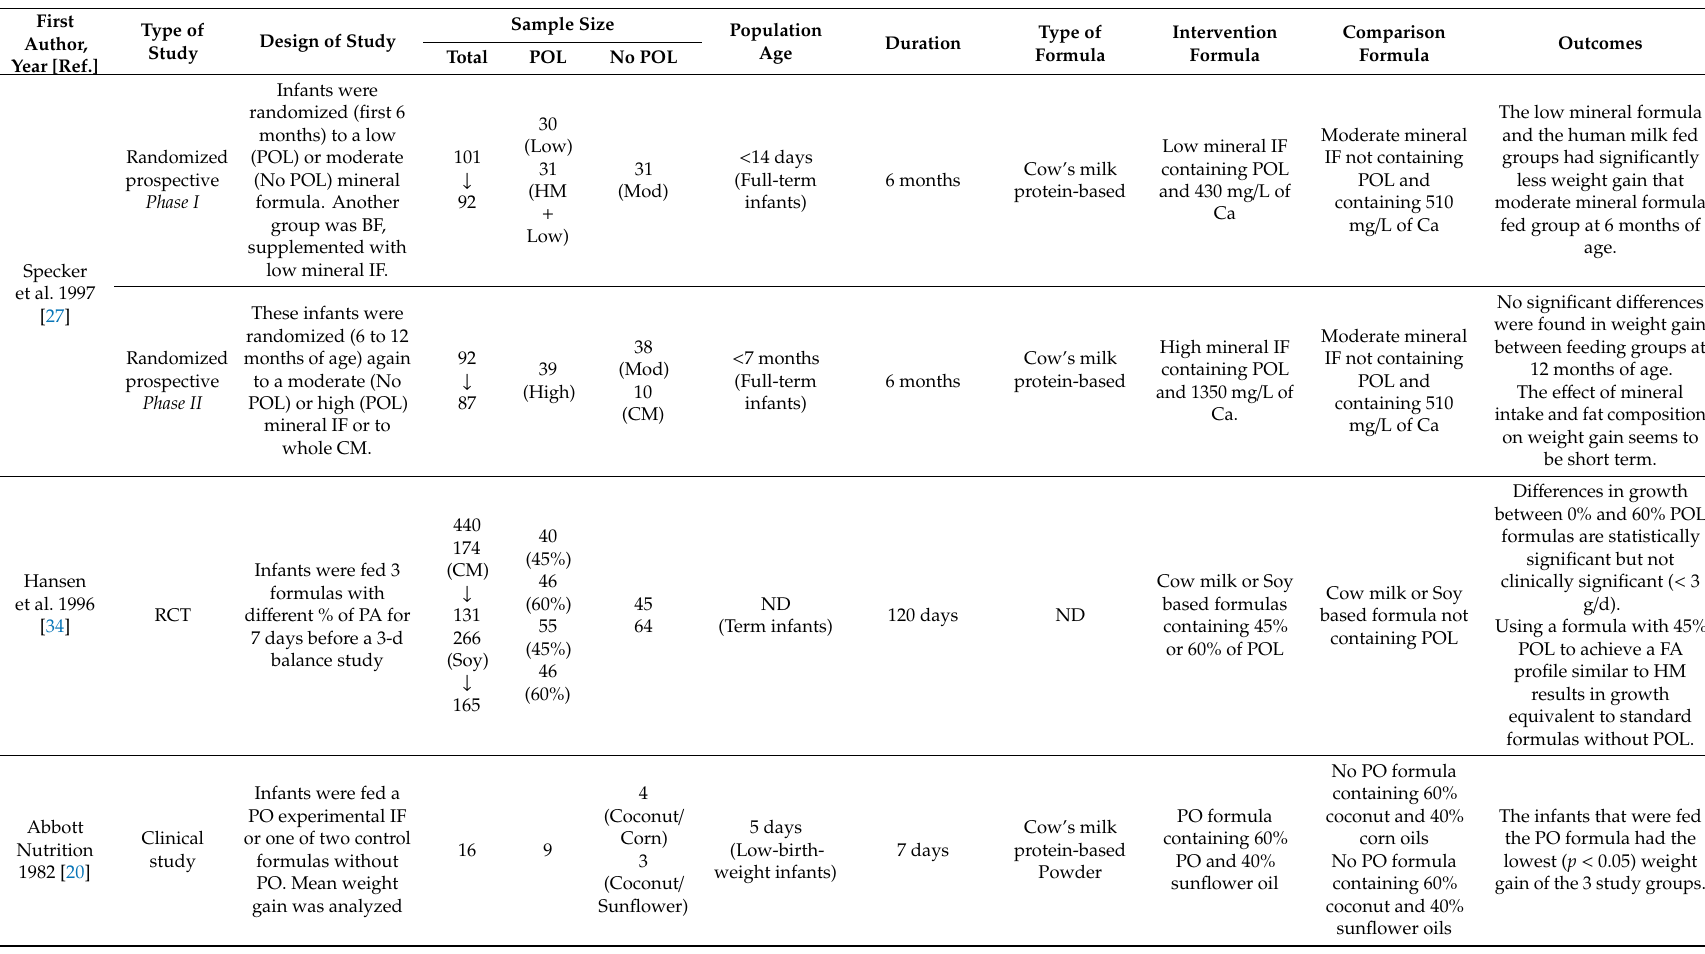
Table 5. Characteristics of studies describing growth and weight gain e ff